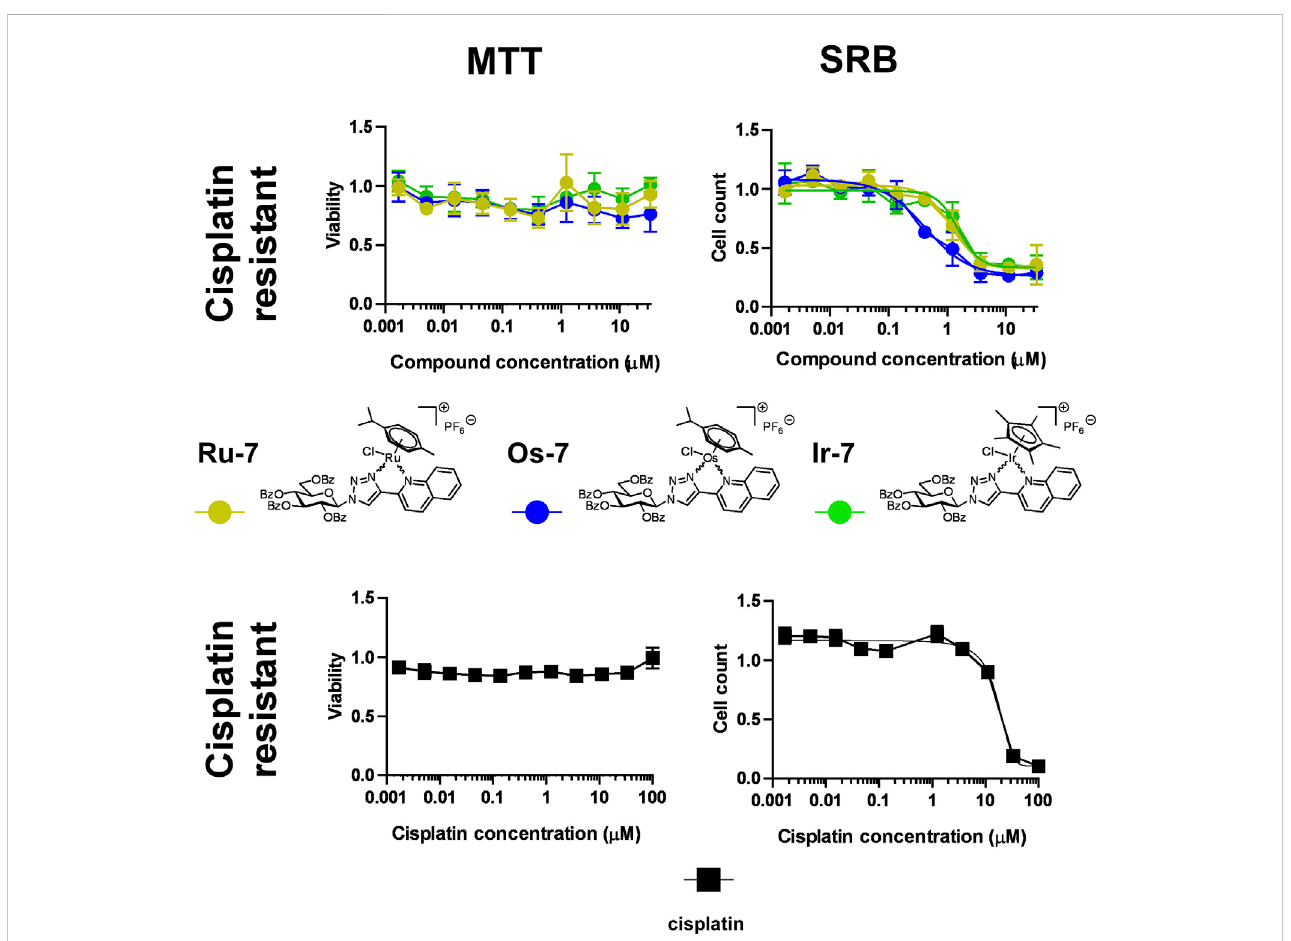
FIGURE 7 Assessment of quinoline-containing complexes Ru-7 , Os-7 , Ir-7 for cytotoxic and cytostatic activity in cisplatin-resistant A2780 cells. 6 × 10 3 cisplatin- resistant A2780 cells were plated to 96 well plates. Cells were treated with the compounds in the concentrations indicated for either 4 h for an MTT assay or for 48 h for an SRB assay. Data is represented as average ± SD, from three biological replicates; individual assays were performed in duplicates. Values were normalized for vehicle treated cells, absorbance for vehicle treated cells equals to 1. Each compound was assessed individually. Normality was assessed using the Shapiro-Wilk test. Normality was achieved using the Box-Cox transformation in the case of Os-7 and Ir-7 datasets, while Ru-7 dataset had normal distribution. Statistical signi fi cance was assessed using One-way ANOVA test comparing all points to the smallest concentration. For better visibility the p values are presented in an excel sheet at https:// fi gshare.com/s/2c942a812caea8869a67. Non-linear regression was performed on the results of the SRB assay